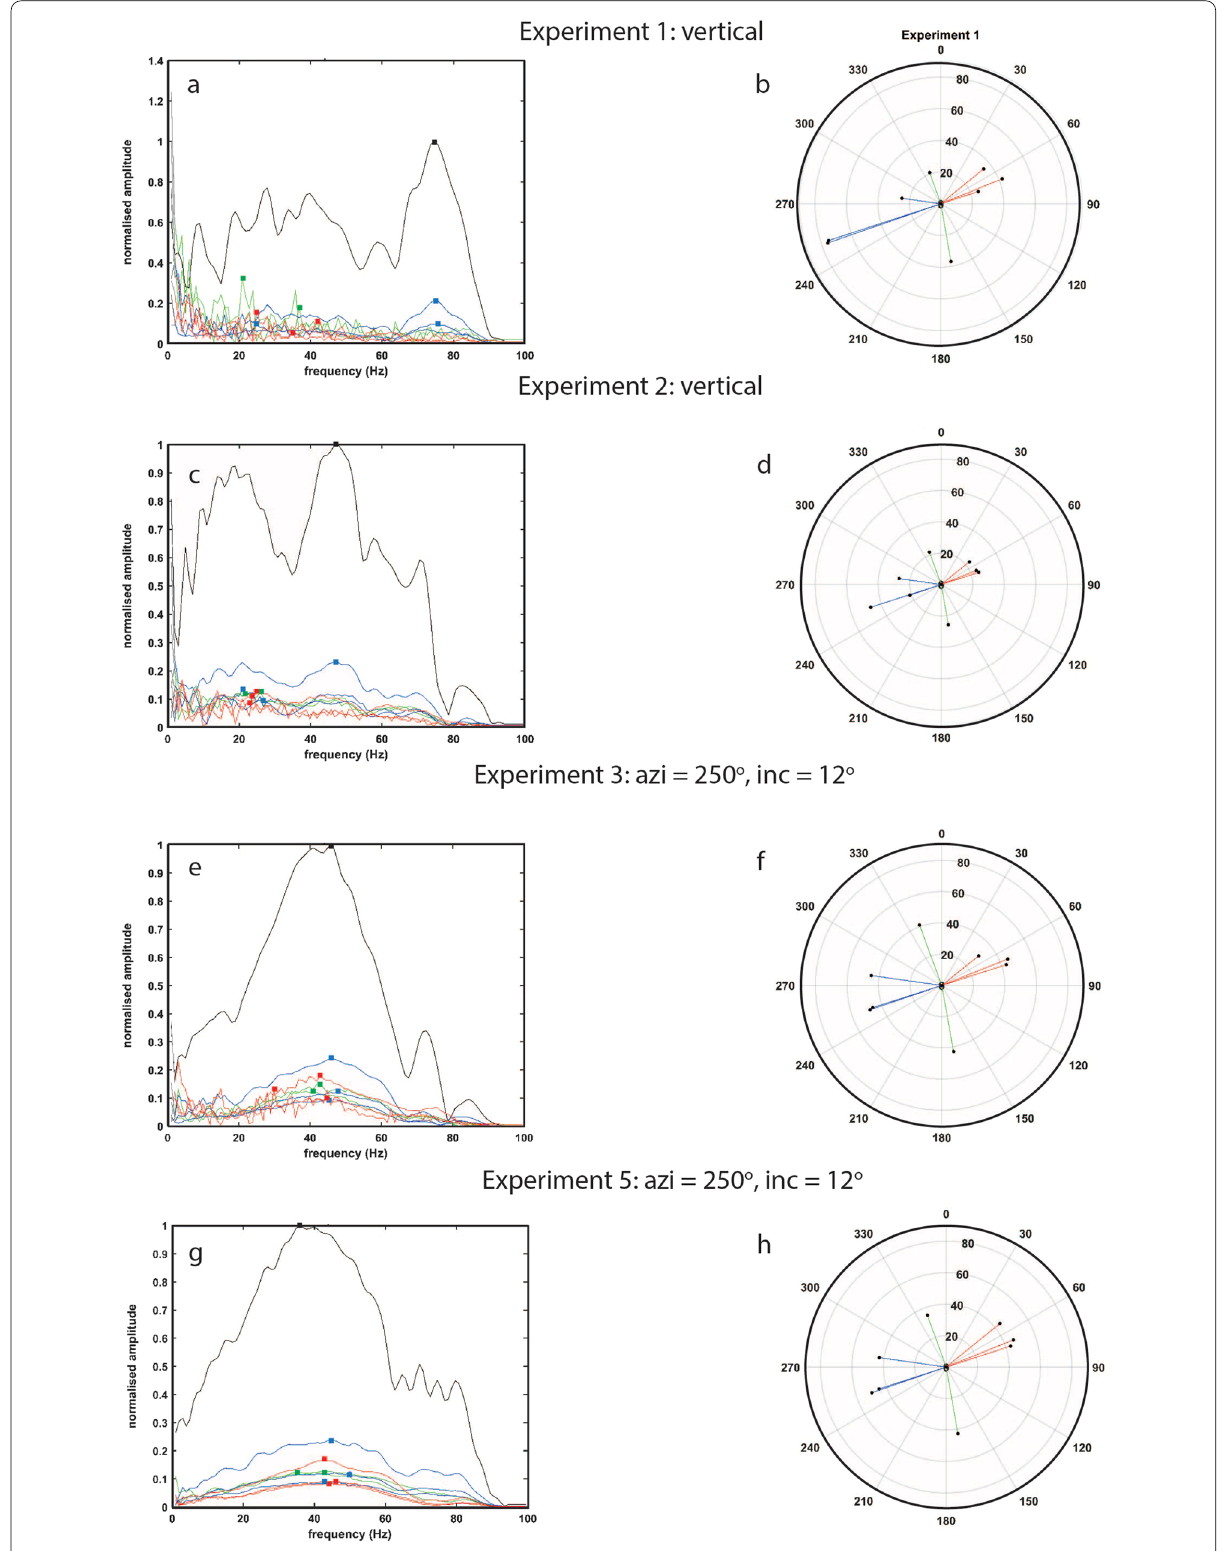
Fig. 4 Complete analysis of eruption data for experiments 1, 2, 3, and 5 following analysis from Fig.